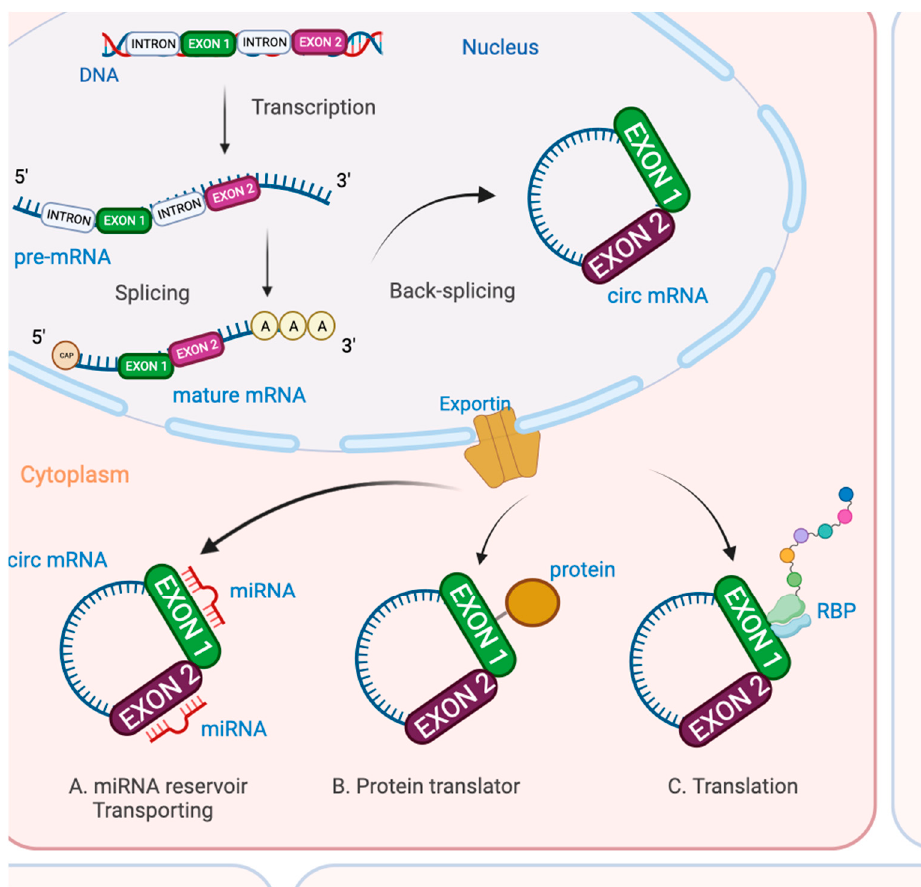
Figure 3. CircRNAs Biosynthesis. Biosynthesis of circular RNA (circ-RNA) are expressed from mostly protein-coding genes. This is a multistep process: firstly, the transcription of pre-messenger-RNA (mRNA), secondly, splicing into mature mRNA and then back-splicing into circ-RNA. Circ-RNA are then exported to the cytoplasm to (A) act as micro RNA (miRNA) reservoirs or transport miRNA; (B) act as protein or peptide translators; and (C) interact with RNA-binding proteins (RBPs) for transcription or translation of genes.